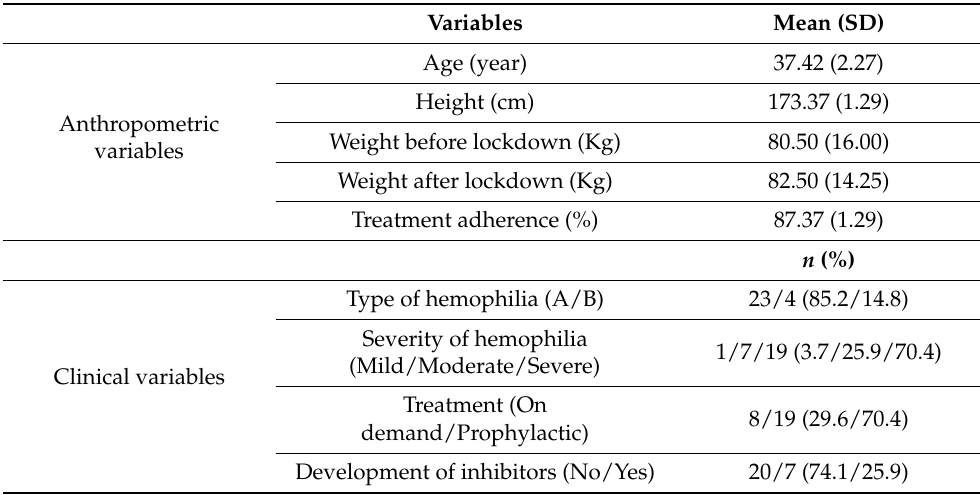
Table 1. Median (and interquartile range) of the descriptive characteristics of the patients with hemophilia included in the study.